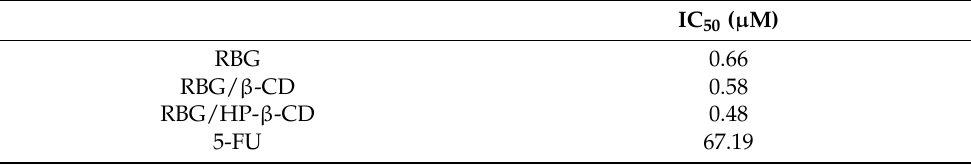
Table 3. In vitro cytotoxicity of RBG and inclusion complex on A549 cells.